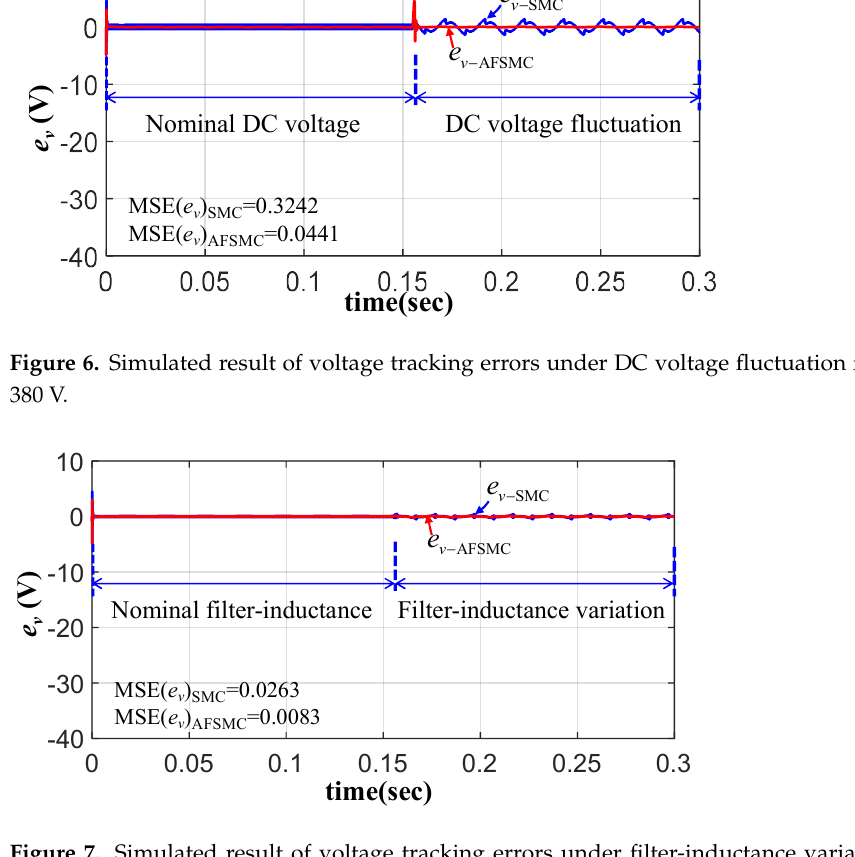
Figure 7. Simulated result of voltage tracking errors under filter-inductance variation from the nominal value of 2 mH to 1.8 mH.